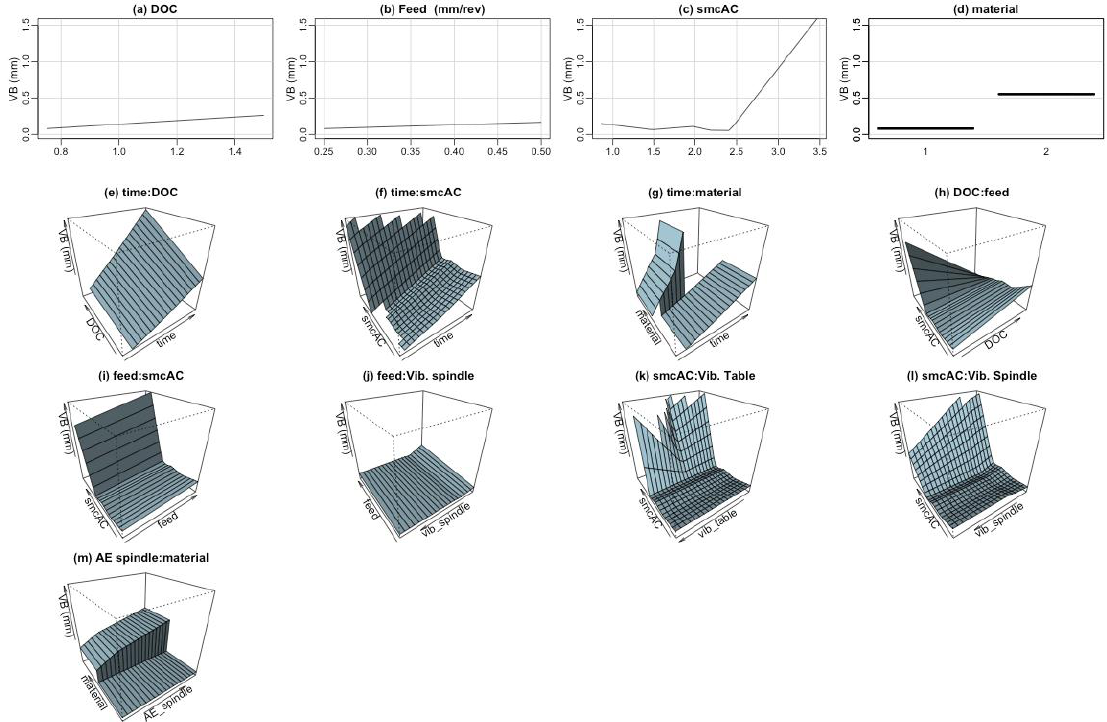
Figure 7. Graphical representation of the terms that constitute the MARS model for the tool flank wear (VB): ( a ) first order term of the predictor variable Depth of cut (DOC); ( b ) first order term of the predictor variable Feed; ( c ) first order term of the predictor variable AC spindle motor current (smcAC); ( d ) first order term of the predictor variable Material; ( e ) second order term of the predictor variables Time and Depth of cut; ( f ) second order term of the predictor variables Time and AC spindle motor current (smcAC); ( g ) second order term of the predictor variables Time and Material; ( h ) second order term of the predictor variables Depth of cut (DOC) and Feed; ( i ) second order term of the predictor variables Feed and AC spindle motor current (smcAC); ( j ) second order term of the predictor variables Feed and Spindle vibration (vib_spindle); ( k ) second order term of the predictor variables AC spindle motor current (smcAC) and Table vibration (vib_table); ( l ) second order term of the predictor variables AC spindle motor current (smcAC) and Spindle vibration (vib_spindle); and ( m ) second order term of the predictor variables Acoustic emission at spindle (AE_spindle) and Material.